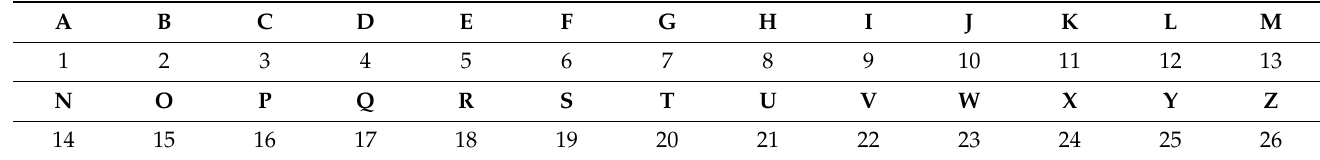
Table 4. Equivalence of the letters of the alphabet in